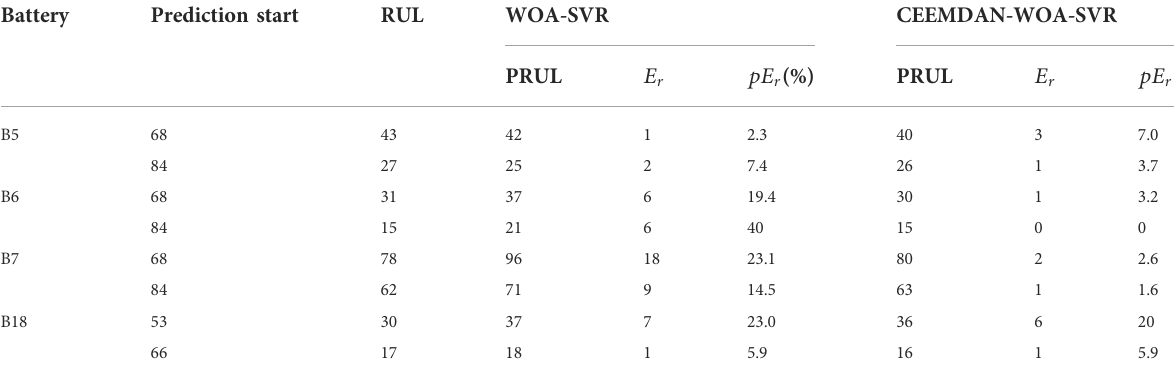
TABLE 2 The RUL prediction results of WOA-SVR and CEEMDAN-WOA-SVR methods.